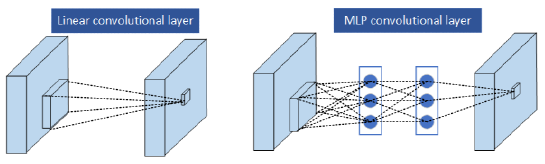
Figure 7. Linear convolutional layer and MLP layer